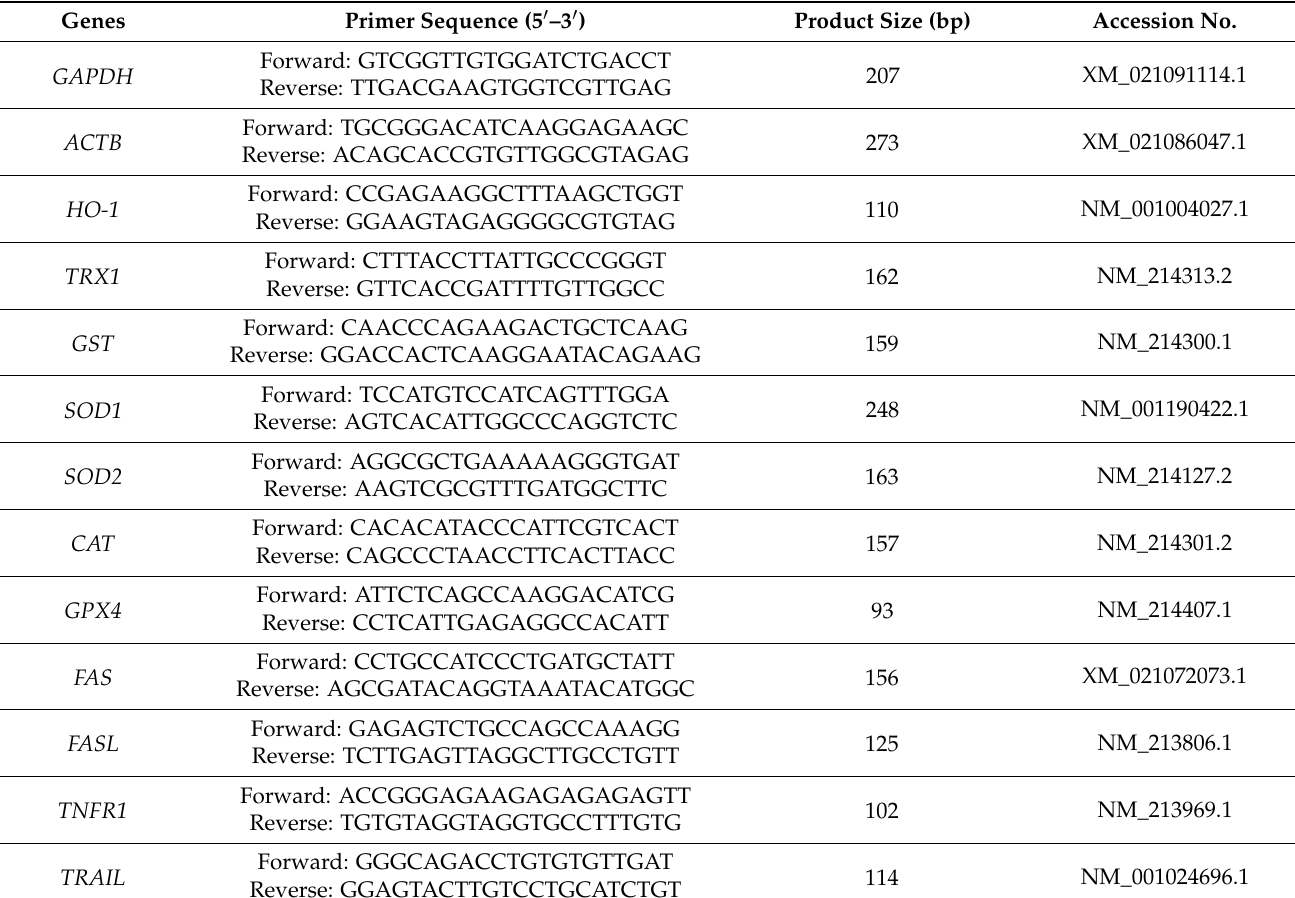
Table 1. Primers for